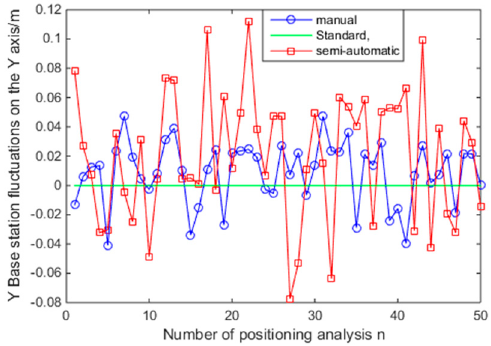
Figure 18. Target positioning error on y axis.